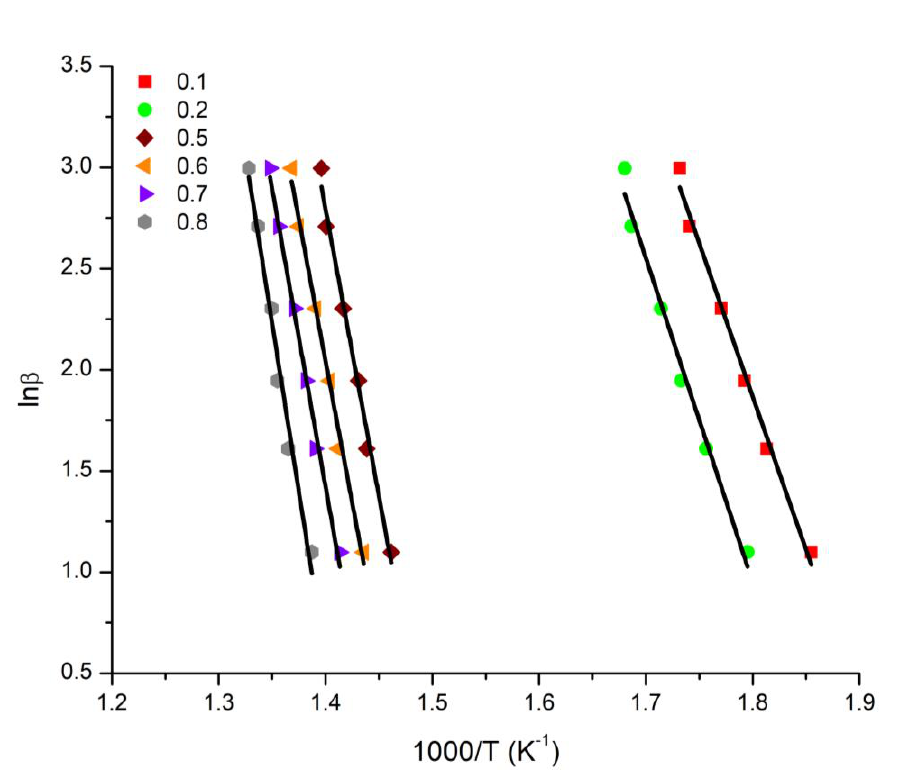
Figure 8. OFW plots for the sample P(NVP–stat–CEVE) 20/80. As the values from OFW and KAS are generally comparable, it can be concluded that these methods are highly accurate at determining the activation energy at different stages of thermal